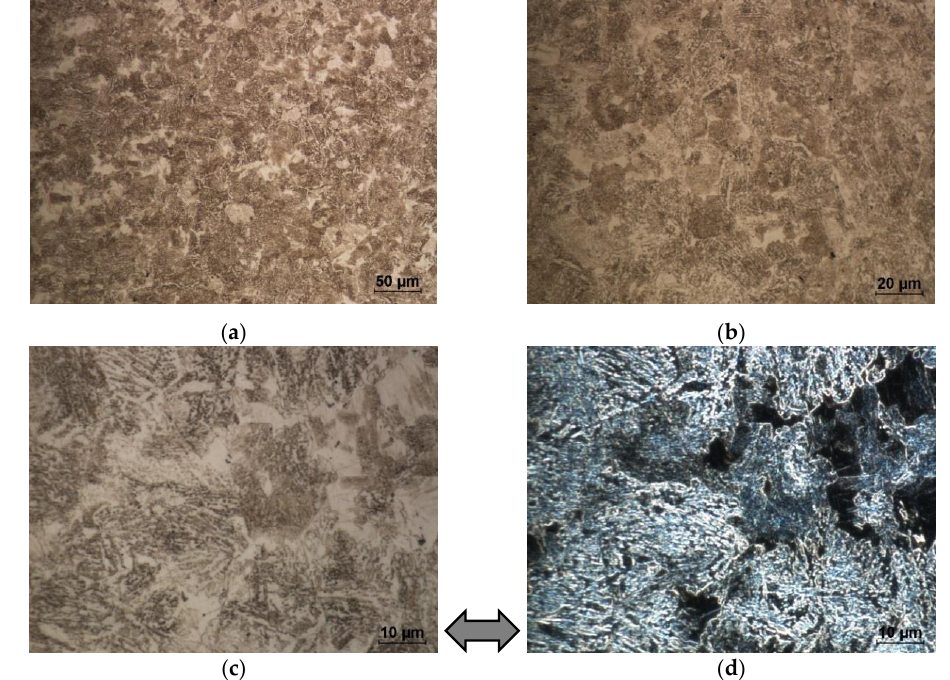
Figure 2. Microstructure of as-received 42CrMo4 steel (S0): ( a–c ) overview of the microstructure observed with different magnifications by bright field technique; ( d ) area from ( c ) photo observed by dark field technique (dark areas—ferrite, bright—cementite). Light optical microscopy (LOM), etched with Nital.